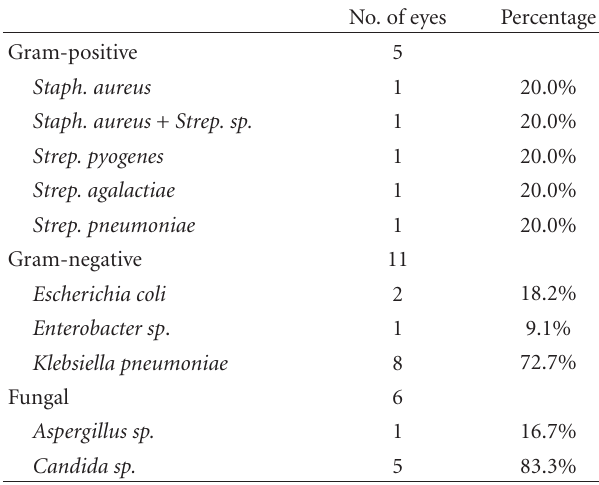
Table 2: Microbiological results of the 22 eyes with endogenous